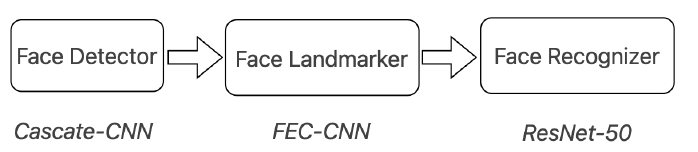
Figure 2. The flow chart of face recognition. Table 4. Typical Opensource Projects for Facial Recognition.